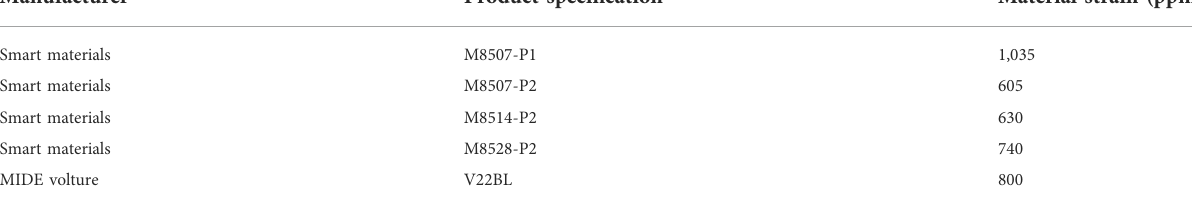
TABLE 3 Material strength of commonly used piezoelectric